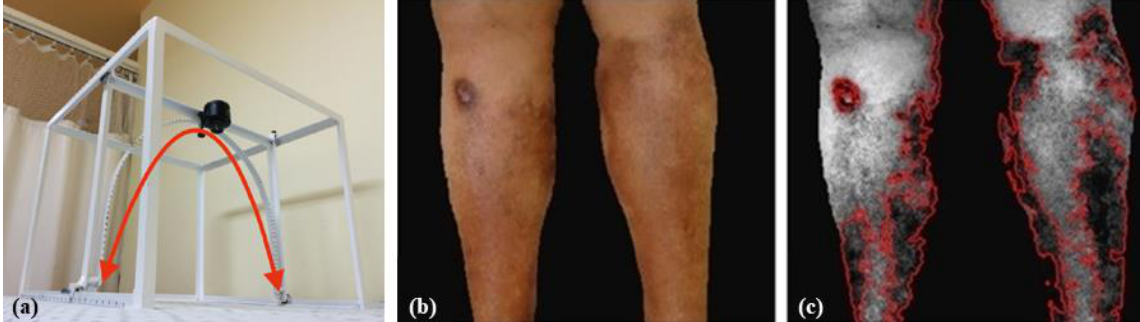
study (skin); ( c ) Selection of atrophic, traumatic and vascular